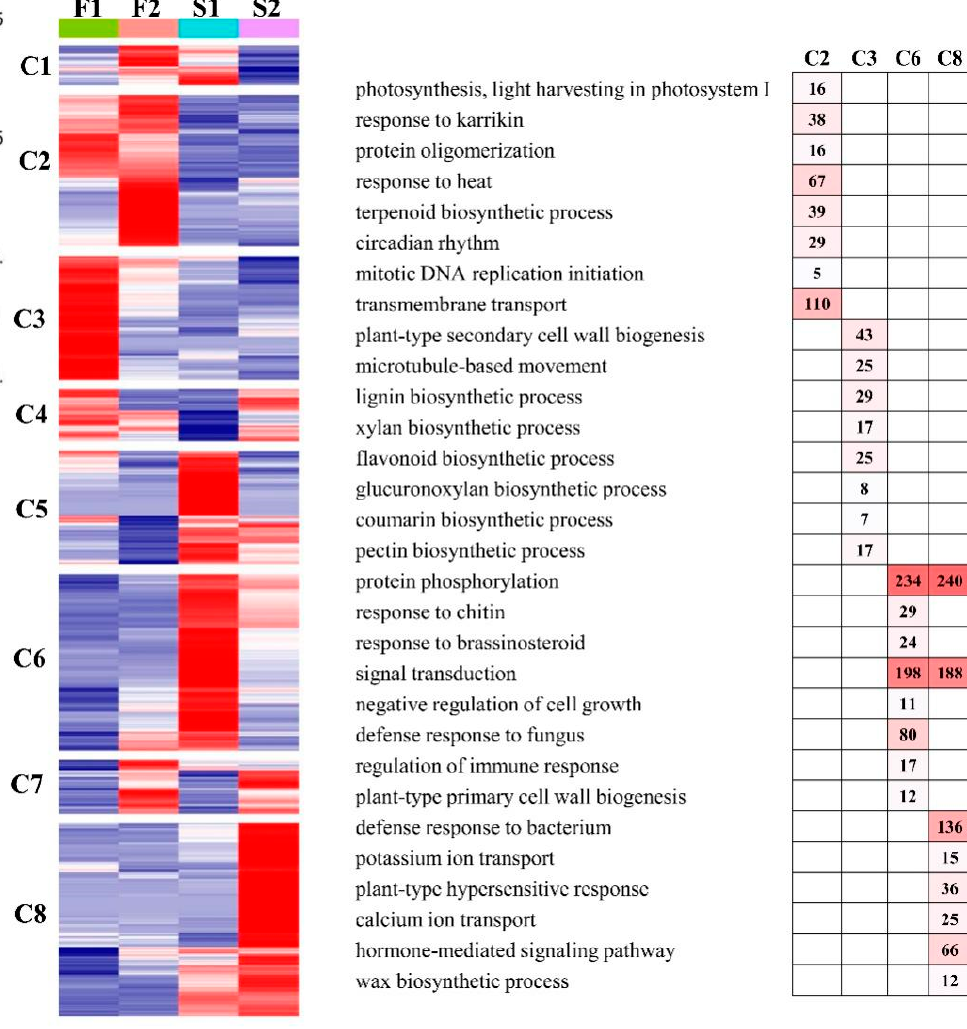
Figure 4. Gene expression pattern and functional transition of fast- and slow-growing genotypes. Expression patterns of 15,411 differentially expressed genes (DEGs) genes in eight DEG clusters. The number of genes in each cluster are shown on the right. Gene ontology (GO) enriched in eight DEGs clusters. Top eight significant categories ( p -value < 0.05) are displayed.